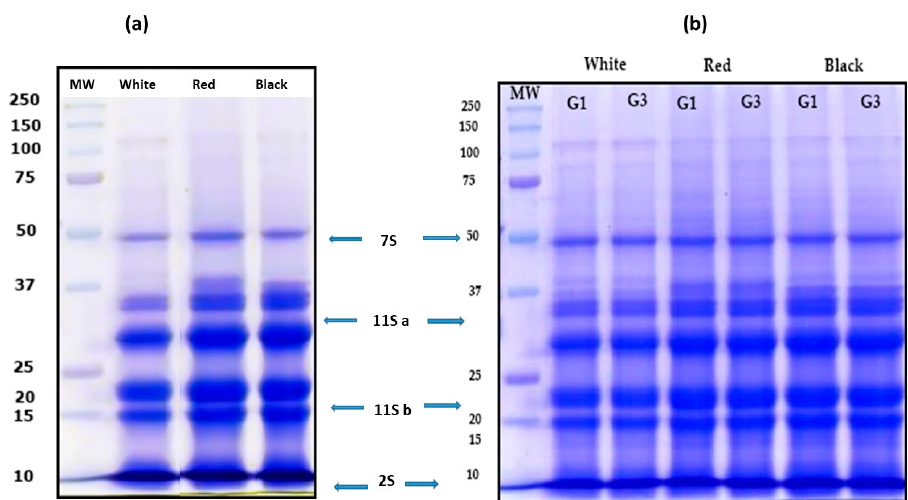
Figure 4. SDS-PAGE analysis of quinoa protein isolate (QPI) obtained from non-germinated and germinated quinoa seeds. ( a ) Profile protein of non-germinated QPI from white, red and black quinoa. ( b ) Profile protein of germinated QPI from white, red and black quinoa. Gel with 12% acrylamide. G1 (1 day of germination) and G3 (3 days of germination).